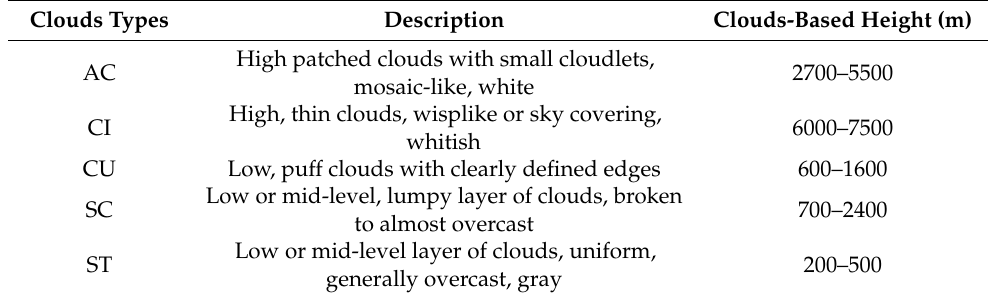
Table 1. Characteristics of various